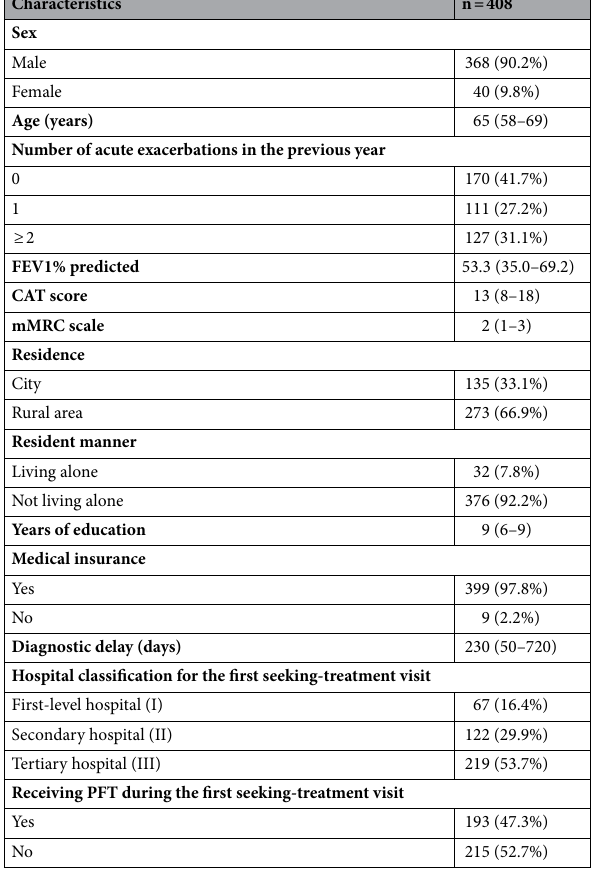
Table 1. Descriptive statistics of the outpatients’ demographic characteristics. FEV1 forced expiratory volume in one second, CAT COPD Assessment Test, mMRC , modified Medical British Research Council, PFT pulmonary function test.